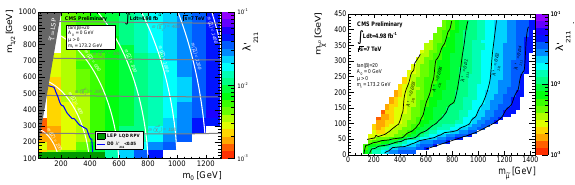
F igure 4. Left : observed 95% CL upper limits on λ (cid:48) as a func- 211 tion of m 0 and m 1 / 2 for A 0 = 0, sign ( µ ) = + 1 and tan β = 20. Right : mSUGRA limits expressed in the parameter space of the neutralino mass m and smuon mass m ˜ µ ˜ χ 0 1